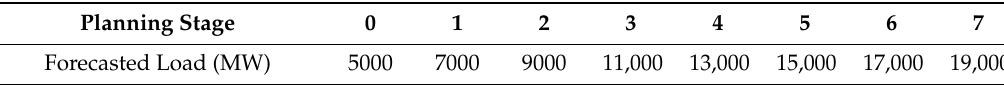
Table 7. Forecast peak load.